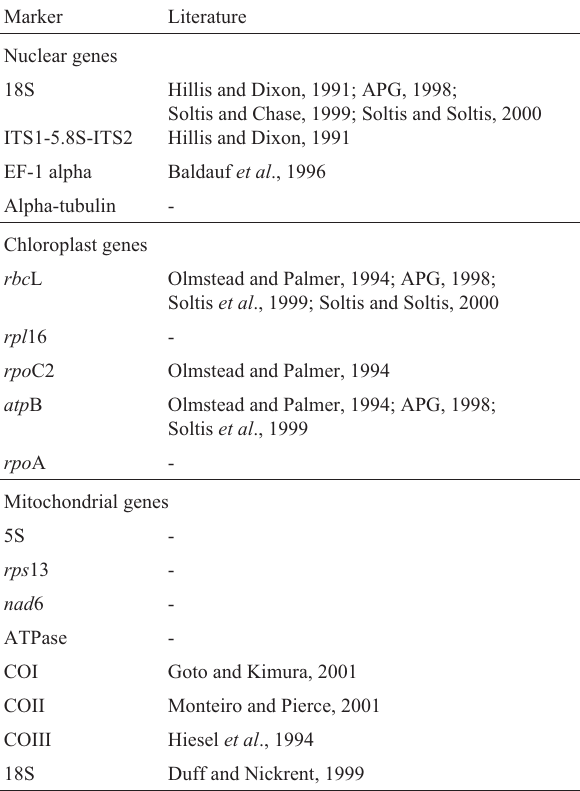
Table I - Molecular markers investigated in sugar cane and previous references to their utilization in phylogenetic studies. (-) indicates that the marker has not yet been used in a phylogenetic